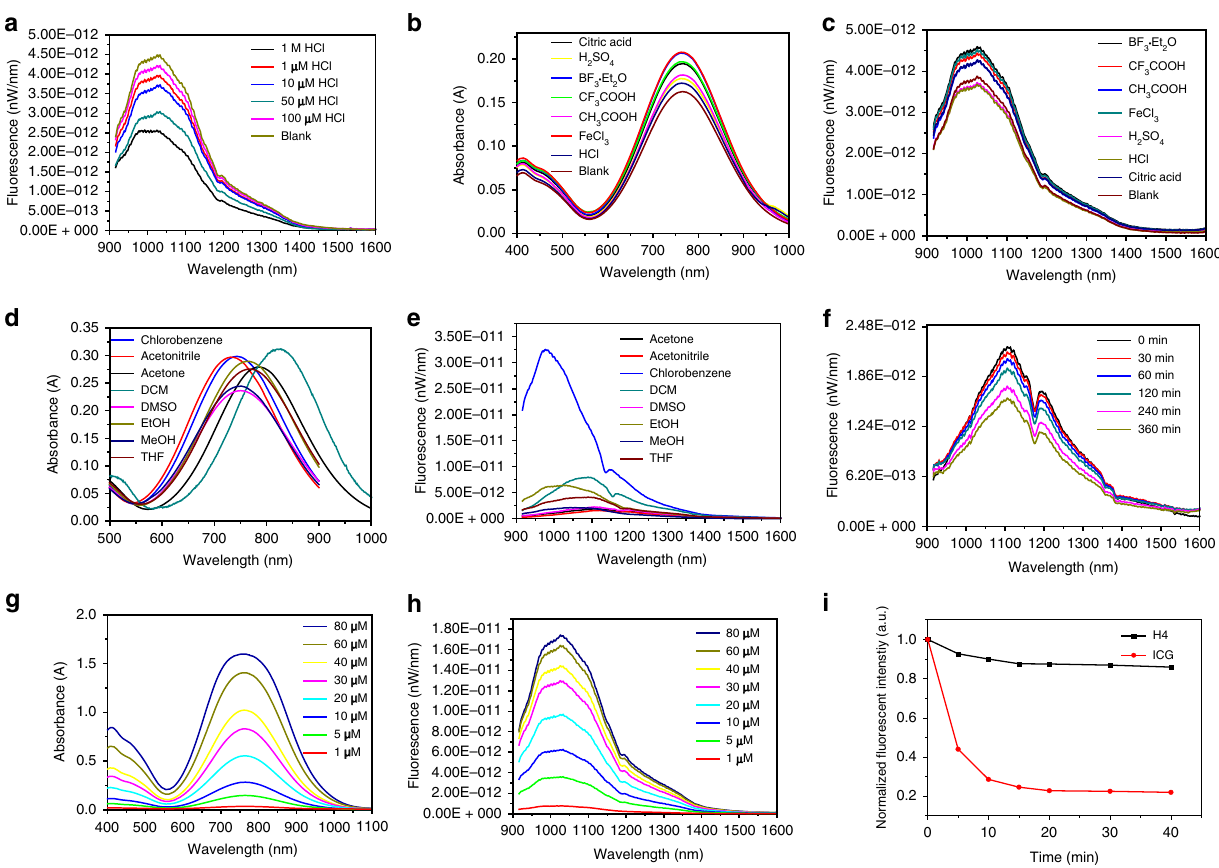
Fig. 4 Spectroscopic properties of H4. a Fluorescent emission of H4 (10 µ M) in EtOH with different concentrations of HCl. b Absorbance and c fl uorescent emission of H4 in different acids. d Absorbance and e fl uorescent emission of H4 in 10 µ M different solvents. f Fluorescent intensity of H4 in DMSO at different times. g Absorbance and h fl uorescent emission of H4 in EtOH with different concentrations. i Compared stability of H4 with ICG in DMSO under continuous 808 nm laser